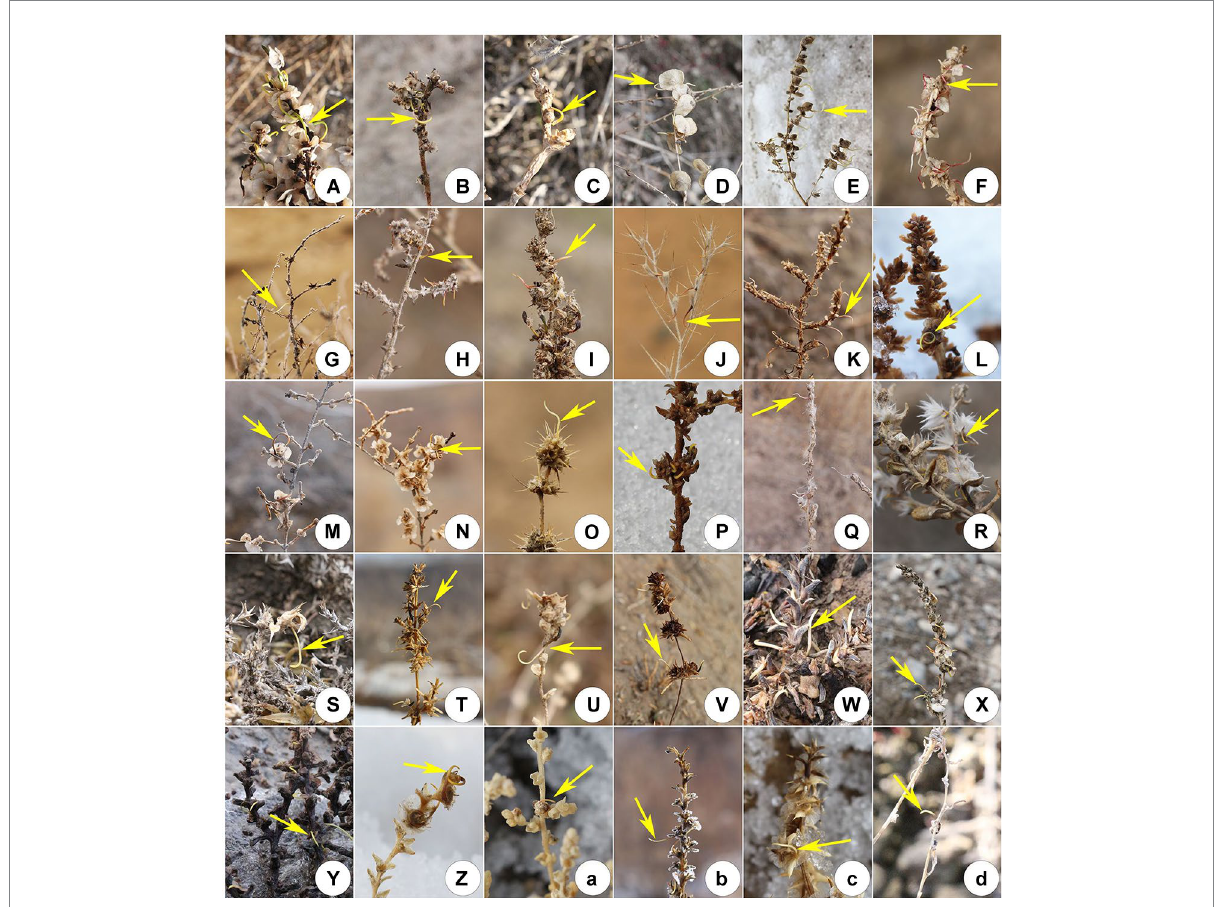
FIGURE 2 Pre-dispersal seed germination of 30 Amaranthaceae species in cold deserts of northern Xinjiang during snow-melting in early spring 2022. (A) Anabasis aphylla ; (B) A. elatior ; (C) A. salsa ; (D) Atriplex aucheri ; (E) A. micrantha ; (F) A. patens ; (G) Bassia dasyphylla ; (H) B. hyssopifolia ; (I) Camphorosma monspeliaca ; (J) Ceratocarpus arenarius ; (K) Girgensohnia oppositiflora ; (L) Halogeton glomeratus ; (M) Haloxylon ammodendron ; (N) H. persicum ; (O) Horaninovia ulicina ; (P) Kochia prostrata ; (Q) K. scoparia ; (R) Krascheninnikovia ceratoides ; (S) Nanophyton erinaceum ; (T) Petrosimonia sibirica ; (U) Salsola affinis ; (V) S. brachiata ; (W) S. collina ; (X) S. dshungarica ; (Y) S. foliosa ; (Z) S. heptapotamica ; (a) S. nitraria ; (b) S. rosacea ; (c) S. ruthenica ; (d) Suaeda glauca